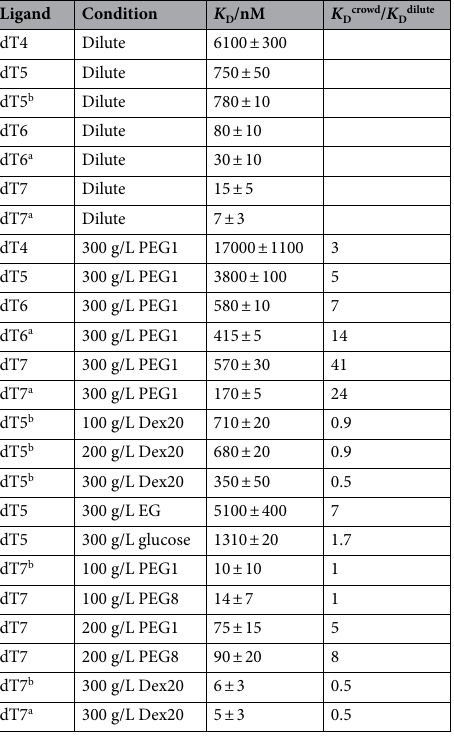
Table 1. Numerical values reporting on the binding affinity, K D , of different oligonucleotides to Bs CspB comparing dilute conditions with crowded environments determined by fluorescence spectroscopy in equilibrium. The concentration of Bs CspB was set to 0.5 µM (indicated with a ), 2.8 µM (indicated with b ) or 4 µM in fluorescence experiments which have been performed at T = 298 K. K D crowd : applying a crowded environment. K D dilute : applying dilute conditions. Associated data are shown in Figs. 2A–D and